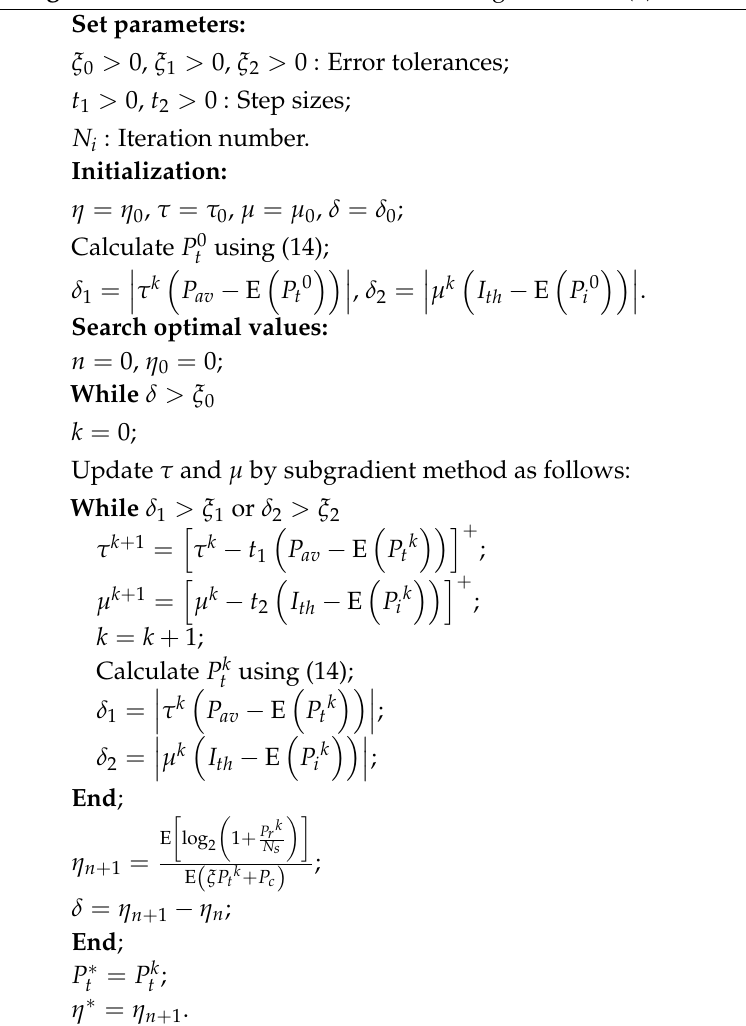
Algorithm 1: Iterative Power Allocation Algorithm for